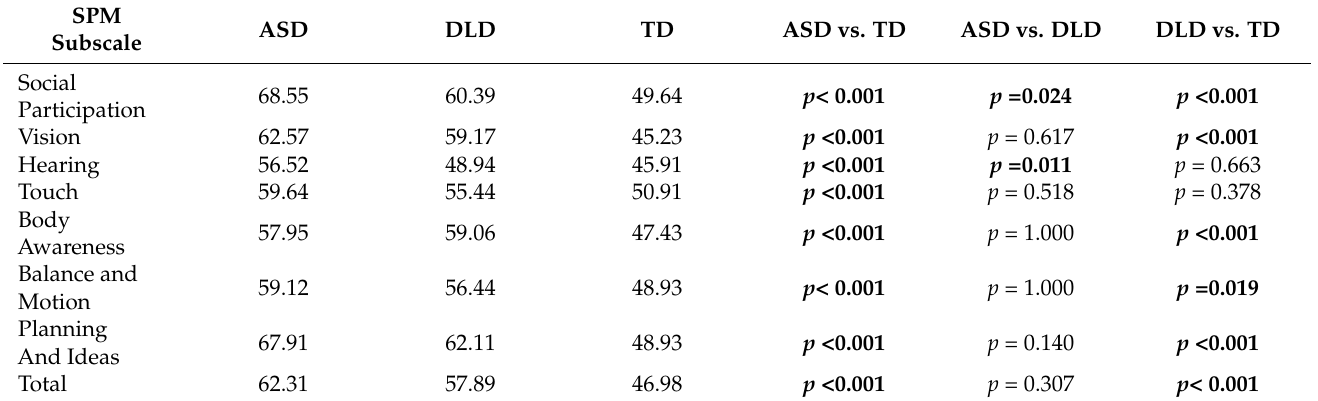
Table 1. Means of the SPM subscales and total score, along with the pair-wise p values ( p < 0.05, p < 0.001).